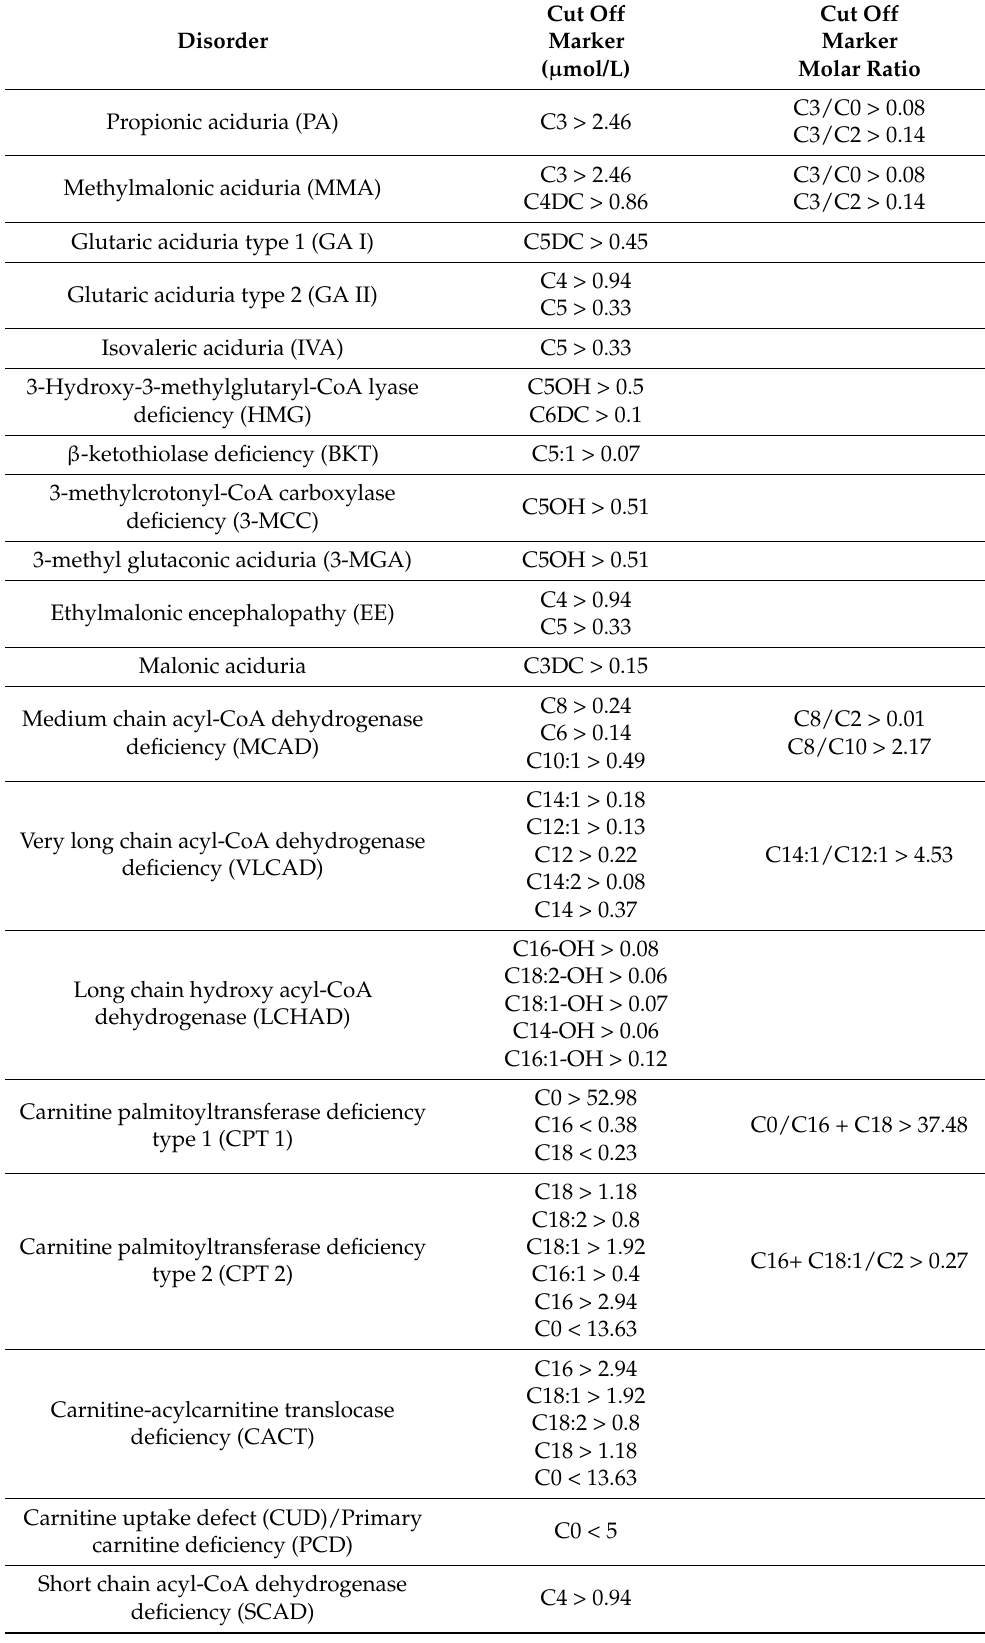
Table 2. Biomarker cut-offs for OAs and